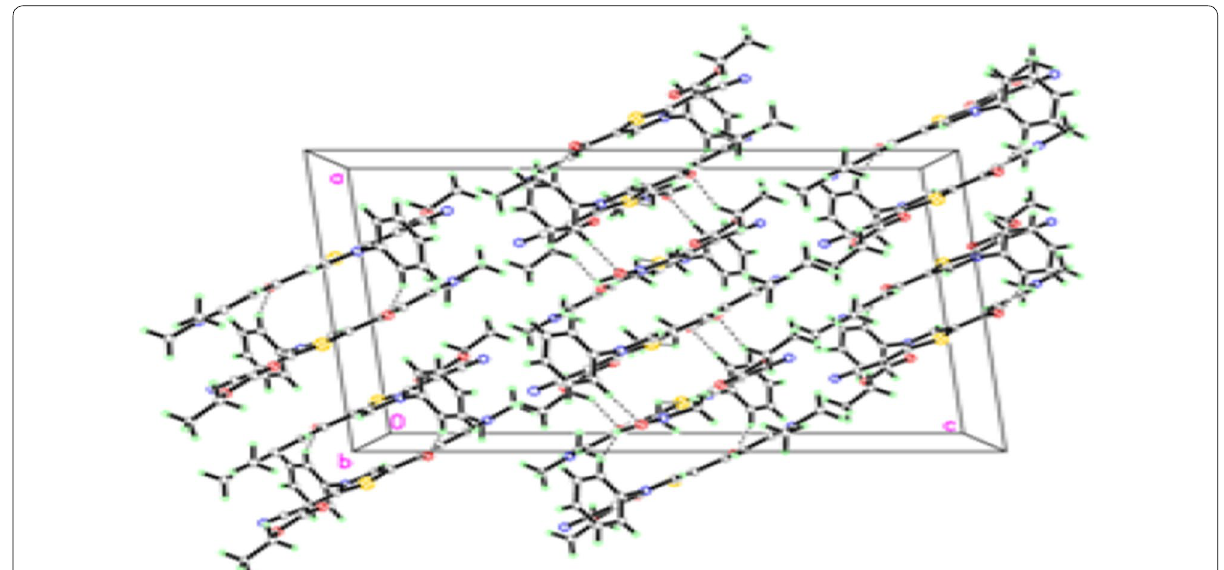
Fig. 4 Molecular packing of thiazole 11 viewed hydrogen bonds which are drawn as dashed